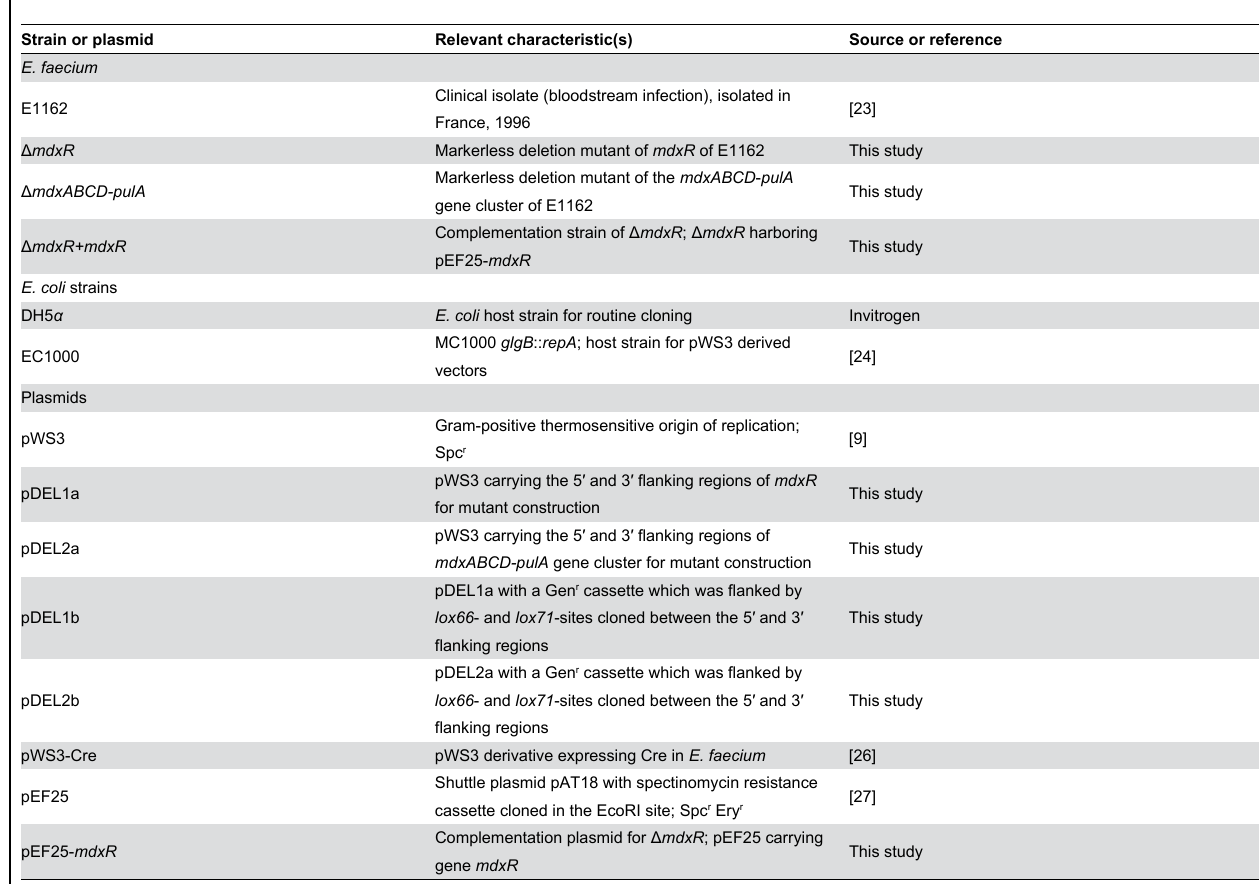
Table 1. Strains and plasmids used in this